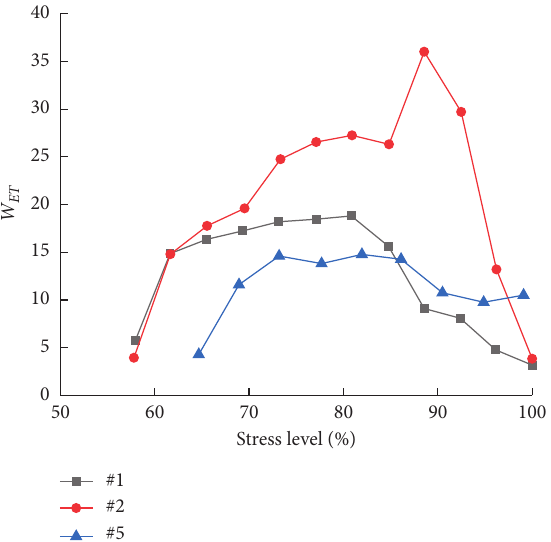
Figure 9: Relationship between the elastic energy index and stress